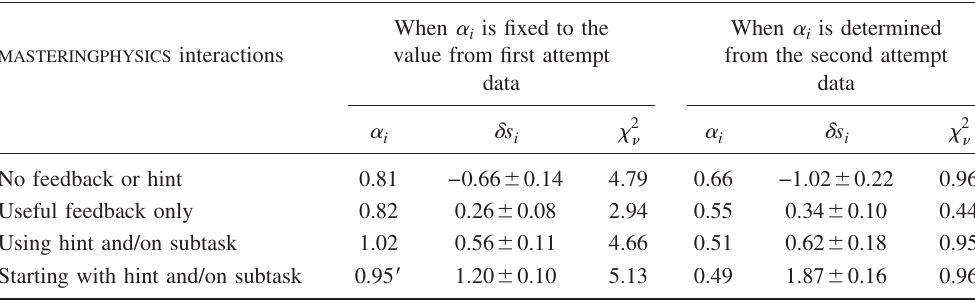
TABLE I. Statistics of changes in skill after various interactions with MASTERINGPHYSICS . When (cid:2) i is fixed to the MASTERINGPHYSICS interactions